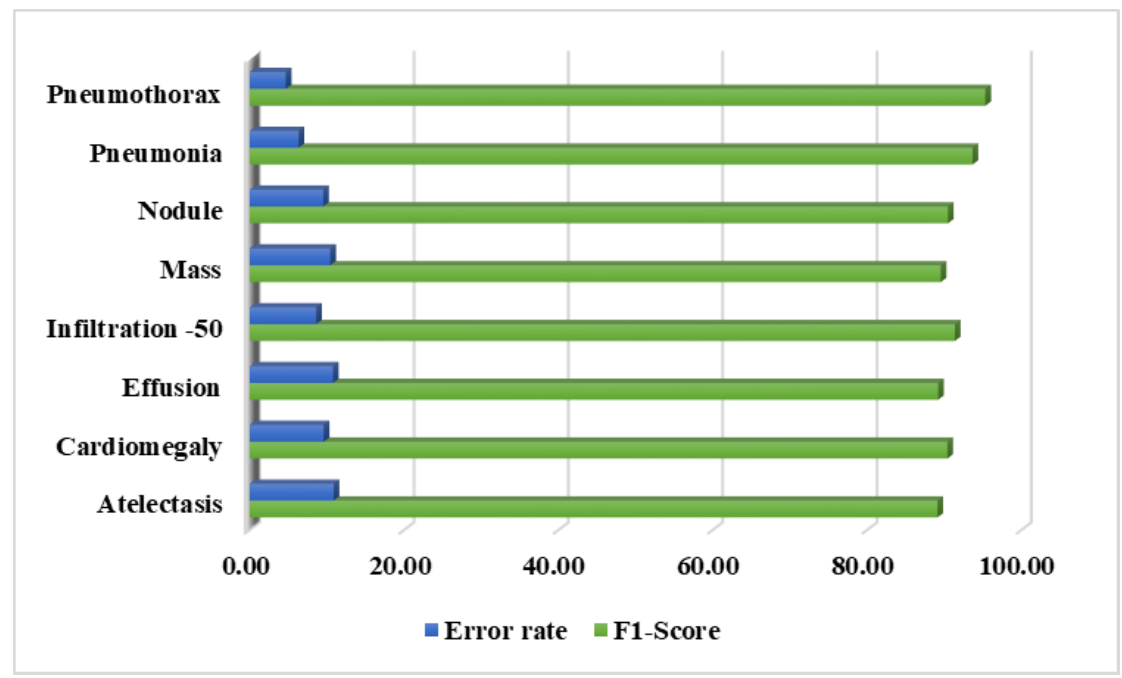
Figure 10. Category-wise F1-measure along with attained error rates for the CXray-EffDet model .